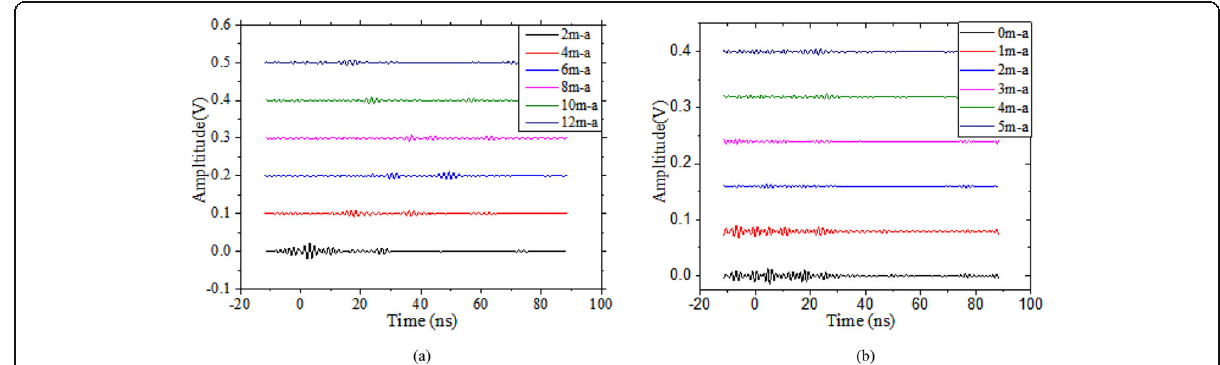
Fig. 12 Signals received by moving antenna. a Perpendicular to moving antenna. b Parallel to moving